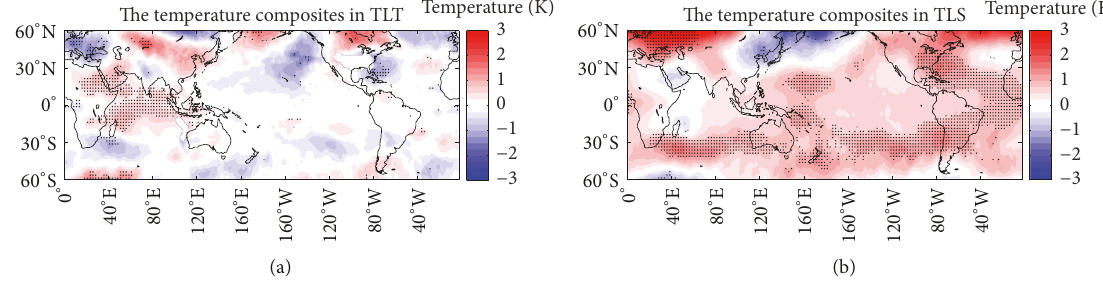
Figure 3: Winter (December-January-February) composites of the SP and SU temperature differences, in which black spots indicate that the differences are significant at the 95% confidence level: (a) TLT; (b)